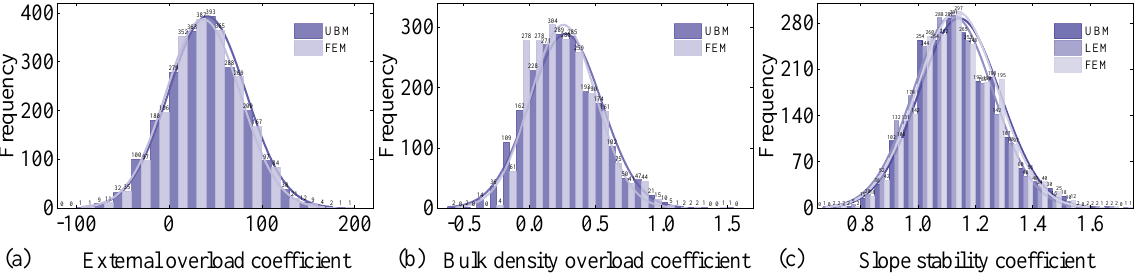
statistics of the slope failure risk.